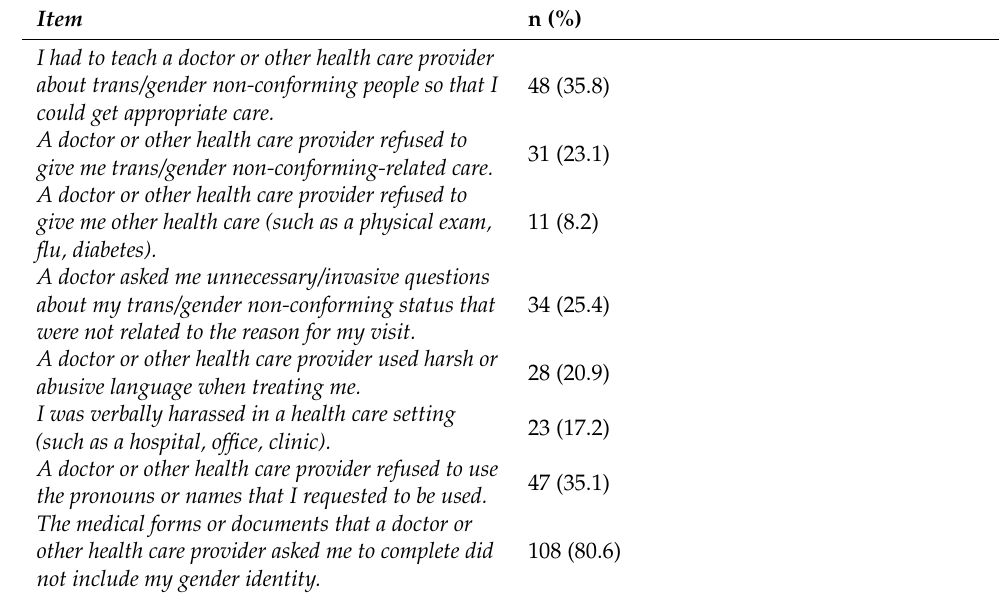
Table 2. Childhood Healthcare Discrimination